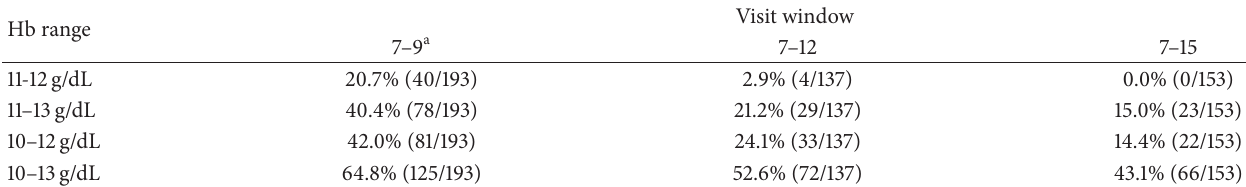
Table 3: Proportion of patients within Hb target ranges (efficacy population).